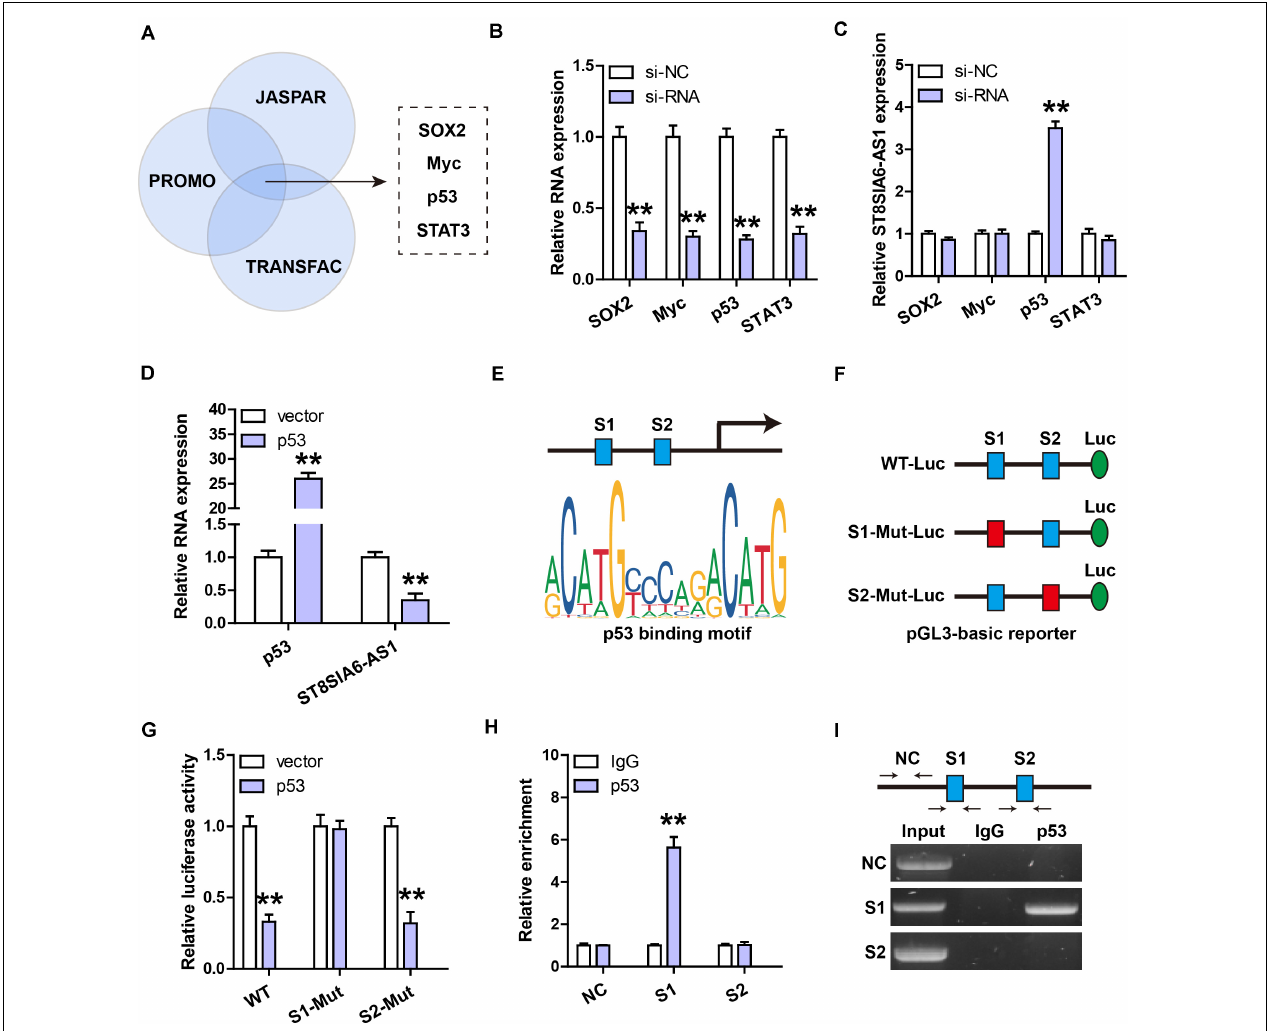
FIGURE 2 | ST8SIA6-AS1 is inhibited by p53. (A,B) Three databases predicting the transcription factors targeting ST8SIA6-AS1. (B) qRT-PCR analysis verifying the silencing efficiency of these indicated four siRNAs. (C) qRT-PCR analysis of ST8SIA6-AS1 expression after knockdown of SOX2, Myc, p53, or STAT3. (D) qRT-PCR analysis of ST8SIA6-AS1 expression after p53 overexpression. (E) Two predicted p53 binding motifs on ST8SIA6-AS1 promoter. (F,G) Luciferase reporter assay was performed using the indicated wily-type and mutant pGL3-basic vector. (H,I) ChIP assay using p53 antibody, followed by PCR analysis of the enrichment of p53 on ST8SIA6-AS1 promoter. ** P <